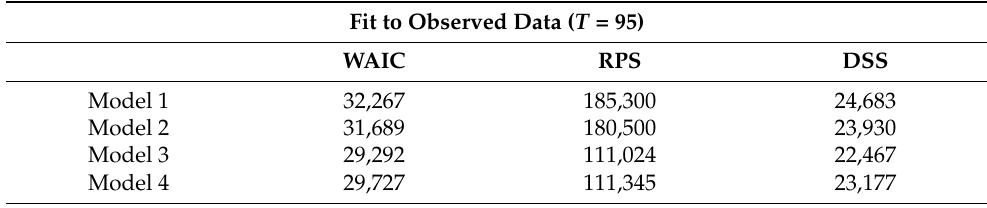
Table 1. Comparative Model Fit, London Boroughs ( N = 32, T = 96).